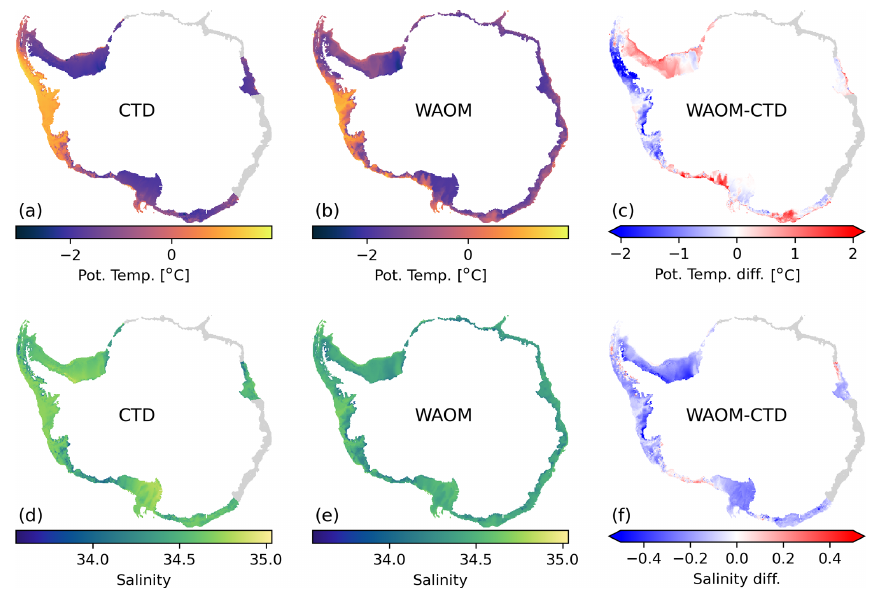
Figure 9. Spatial distribution of on-shelf bottom layer hydrography compared against observations. Panels (a) and (d) are multi-decadal means of potential temperature and practical salinity from Schmidtko et al. (2014). Panels (b) and (e) are 2007 means of the same quantities as predicted by WAOM, and panels (c) and (f) are the differences between the model and the observations (WAOM – CTD). For the analysis bottom layer CTD measurements have been converted to model quantities (conservative temperature to potential temperature; absolute salinity to practical salinity) and interpolated onto the model grid using the nearest-neighbour scheme. Model data have been interpolated to the same depth as the observations using the nearest-neighbour scheme. Regions with sparse observations have been excluded from the analysis (western East Antarctica and Sabrina Coast; see Fig. 1 for sector boundaries).